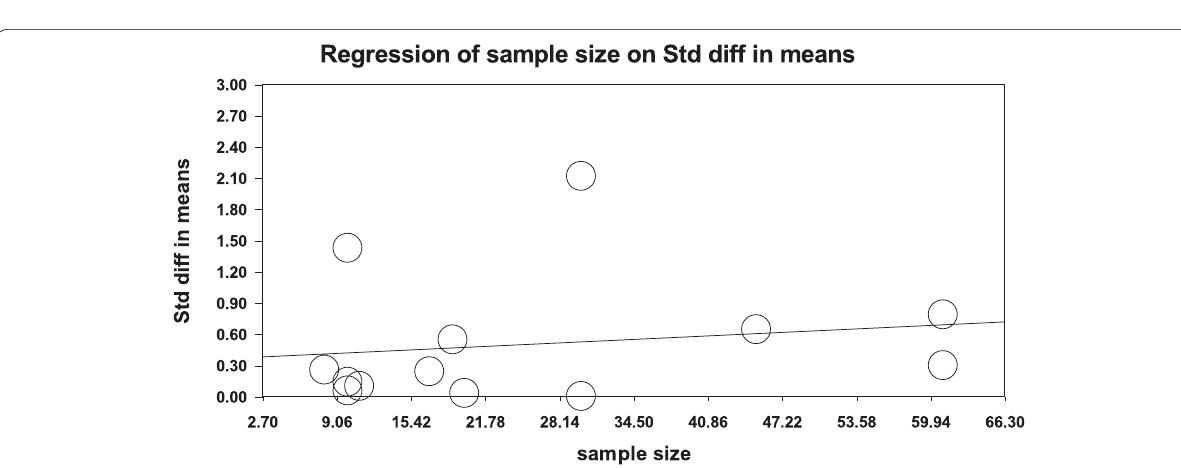
Fig. 7 The meta-regression of the relationship between the sample size and SMD before and after the intervention in the control and intervention